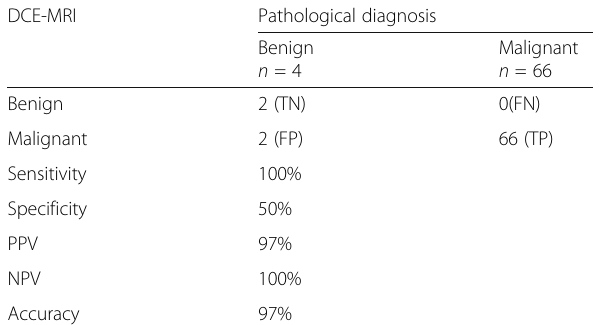
Table 2 The diagnostic performance of DCE-MRI in diagnosis of cervical carcinoma